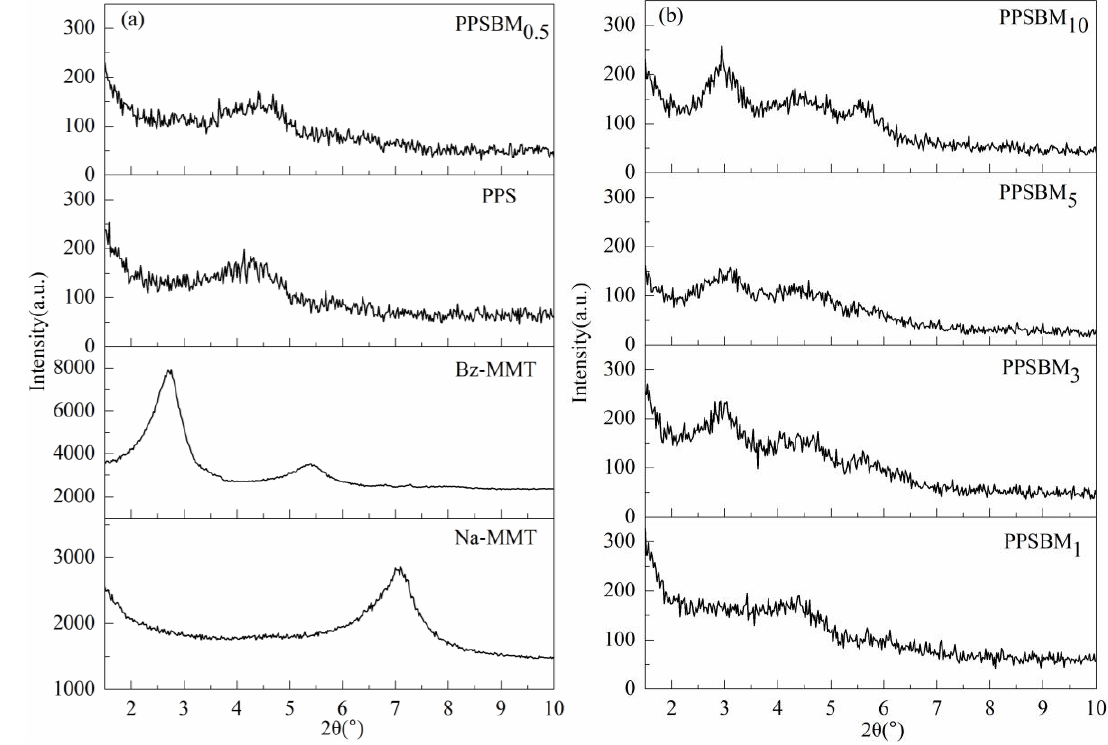
Figure 1. XRD patterns of pure polyphenylene sulfide (PPS) and PPSBM x composites: ( a ) Na–MMT, Bz–MMT, PPS and PPSBM 0.5 ; ( b ) PPSBM 1 , PPSBM 3 , PPSBM 5 and PPSBM 10 .